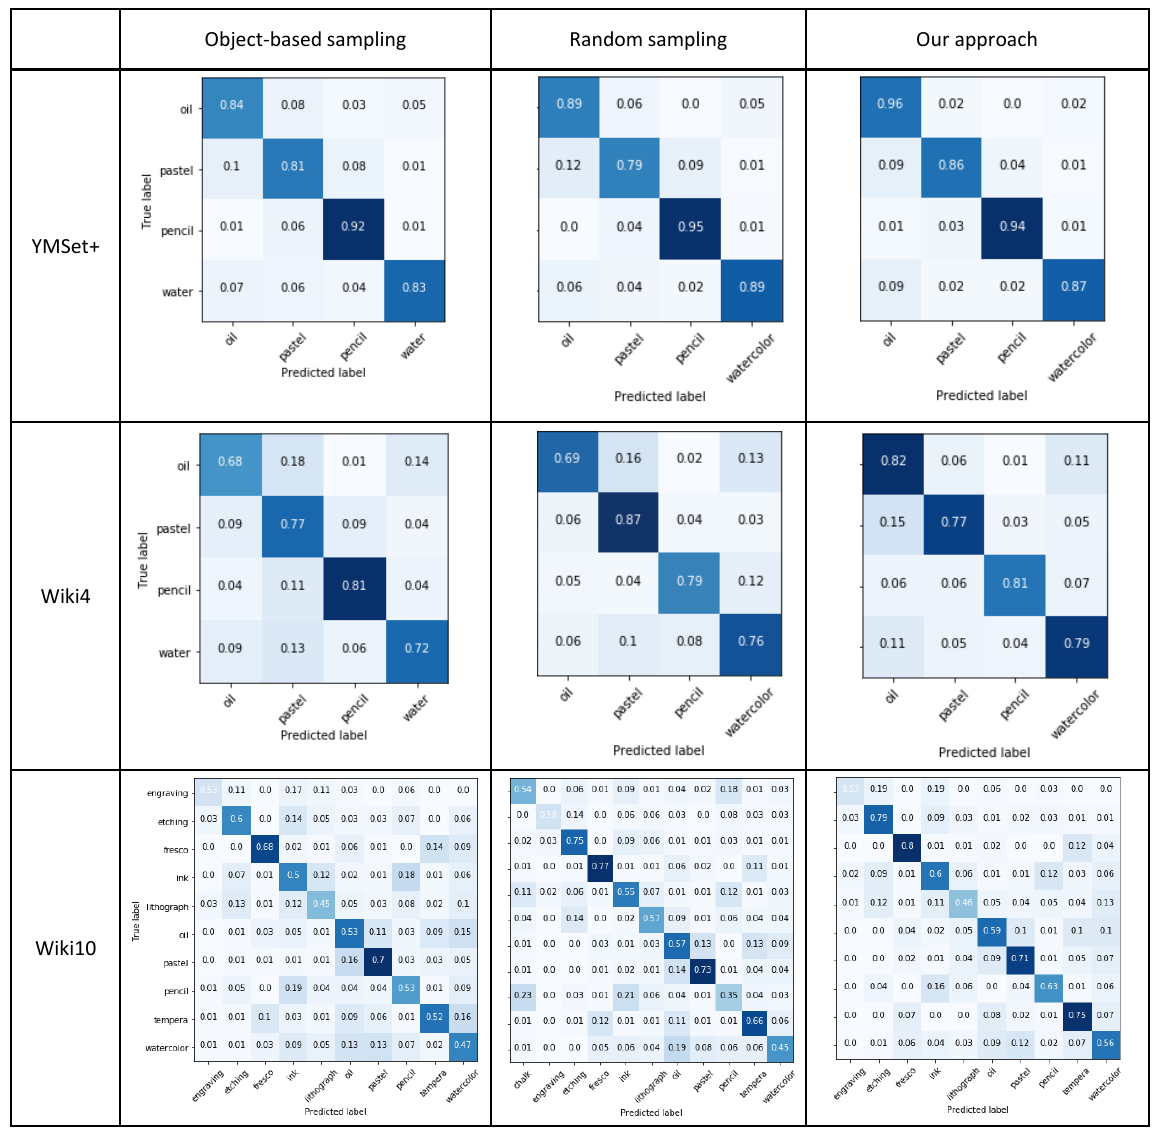
Figure 19. Comparison of confusion matrices: Row denotes the dataset and column denotes sampling